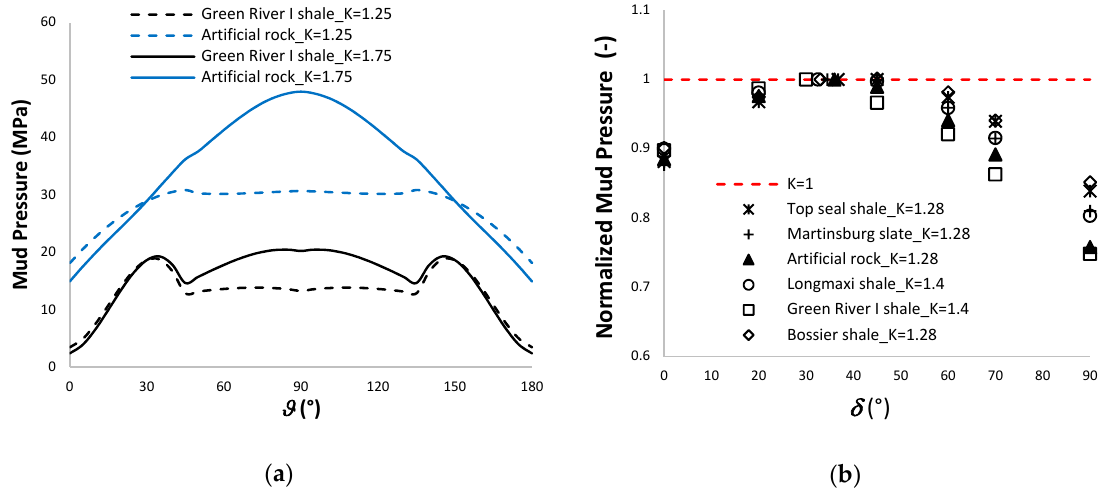
Figure 16. ( a ) Trend of the mud pressures at δ = 90° and effect of the in situ stress anisotropy ( K = σ MAX / σ min ) on the mud pressure pattern σ min = 40 MPa, P f = 35 MPa. ( b ) Peaks of the mud pressures at different δ normalized with the mud pressures calculated at δ = δ crit . The dotted red line represents the normalized mud pressure when K = σ MAX / σ min = 1.